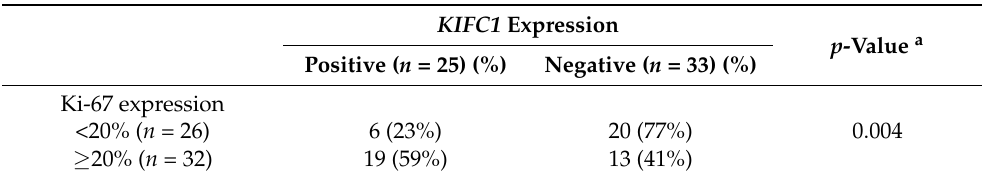
Table 4. Relationship between KIFC1 expression and Ki-67 in the 58 bladder cancer from Hi- cohort. roshima cohort.